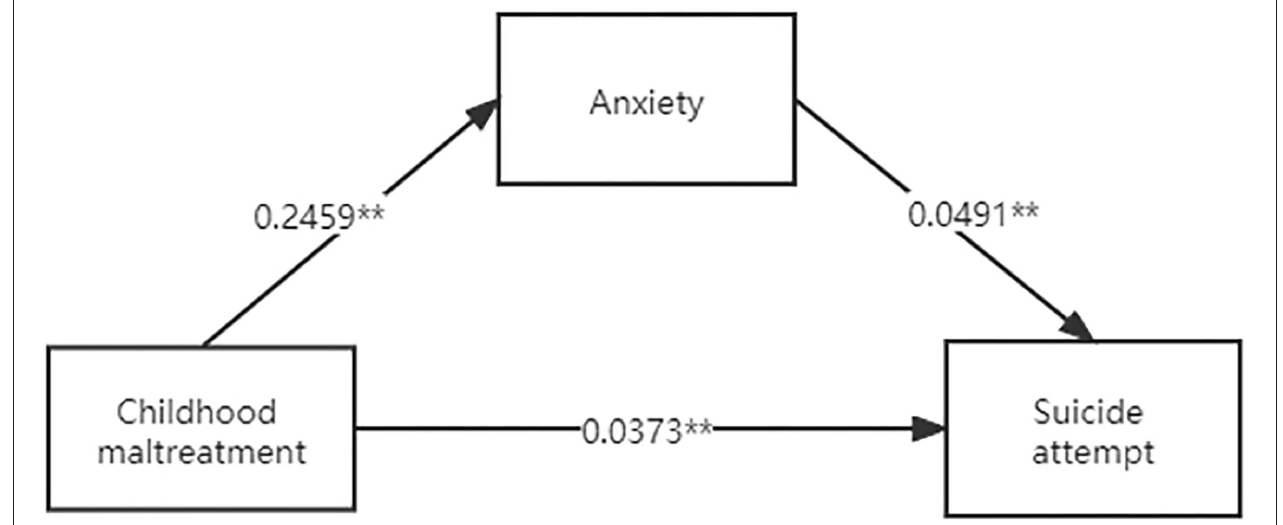
FIGURE 1 | The mediation effect of anxiety on the relationship between childhood maltreatment and SA. ** P < 0.01.